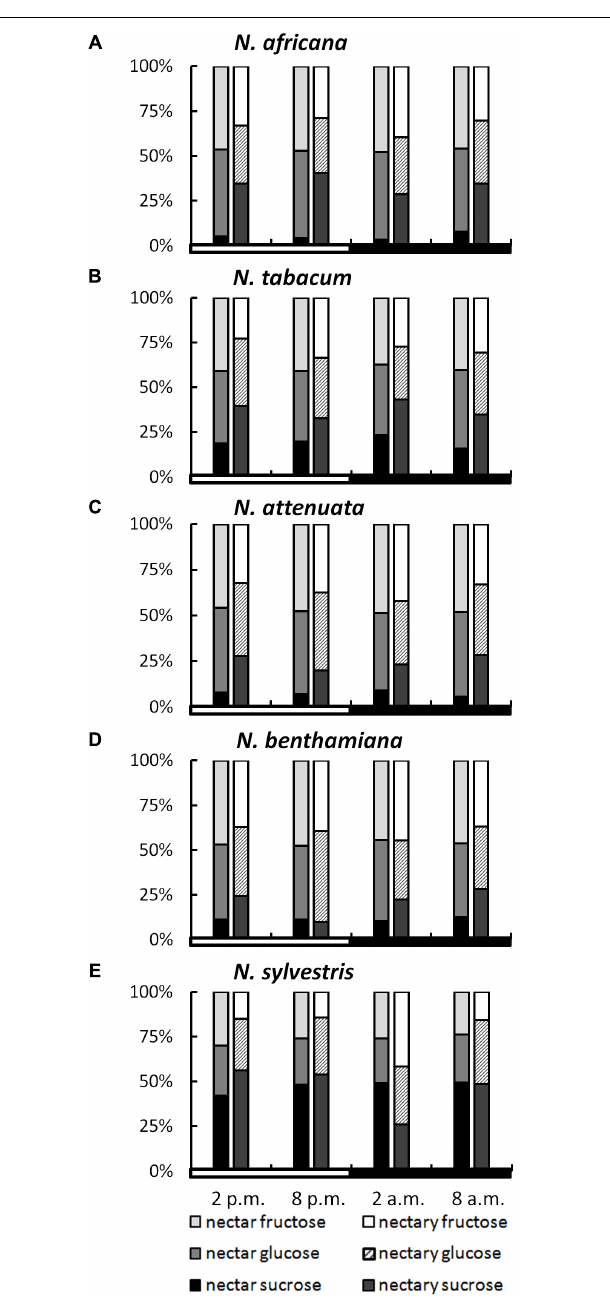
FIGURE 3 | Sugar percentages in nectaries and nectar. All percentages were calculated from mM; n = 3; light and dark periods are indicated by white and black bars; one pair of bars indicates one time point of sampling, with the Left bar representing nectar and the Right bar representing nectaries. (A) N. africana , (B) N. tabacum , (C) N. attenuata , (D) N. benthamiana , and (E) N. sylvestris